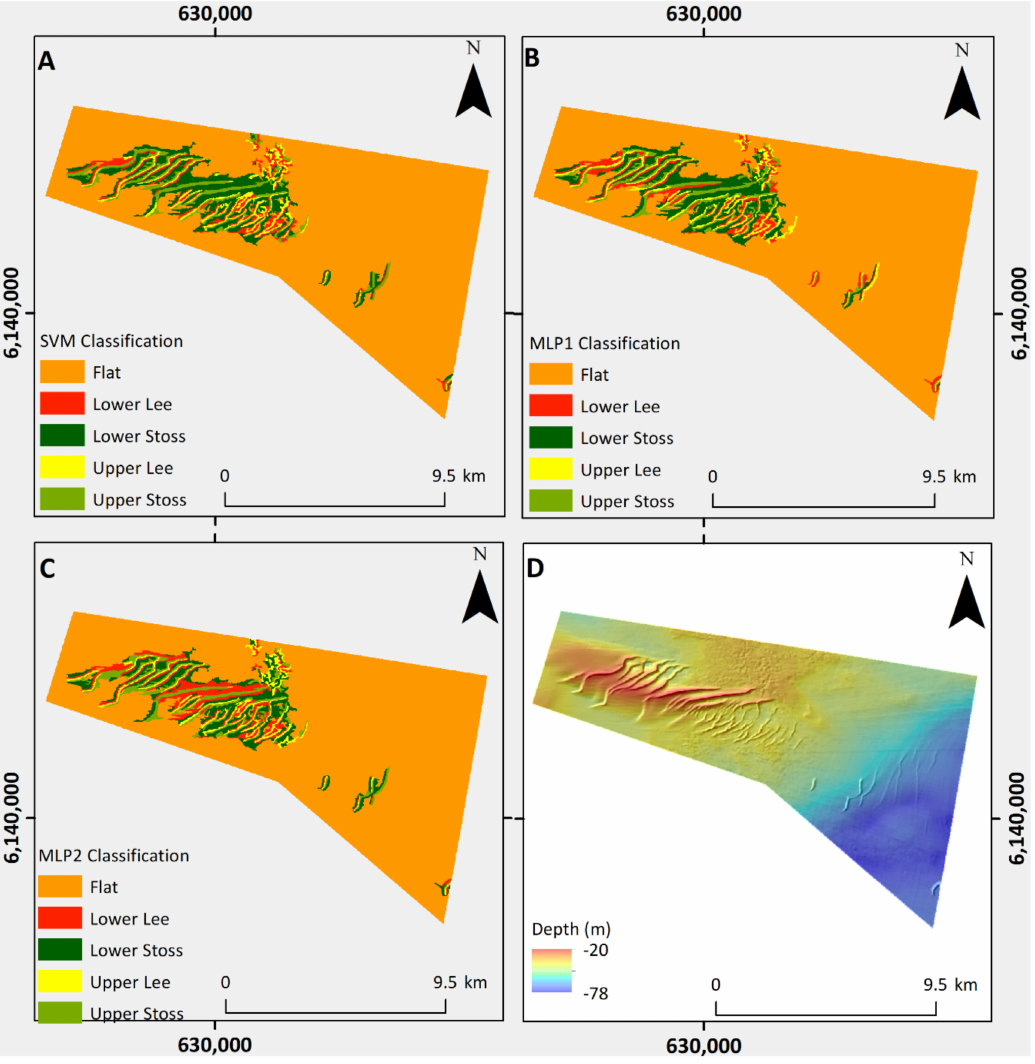
Figure 10. Classification maps for the ( A ) SVM, ( B ) MLP1, and ( C ) MLP2 classifiers, and ( D ) the bathymetry for the HTB SAC